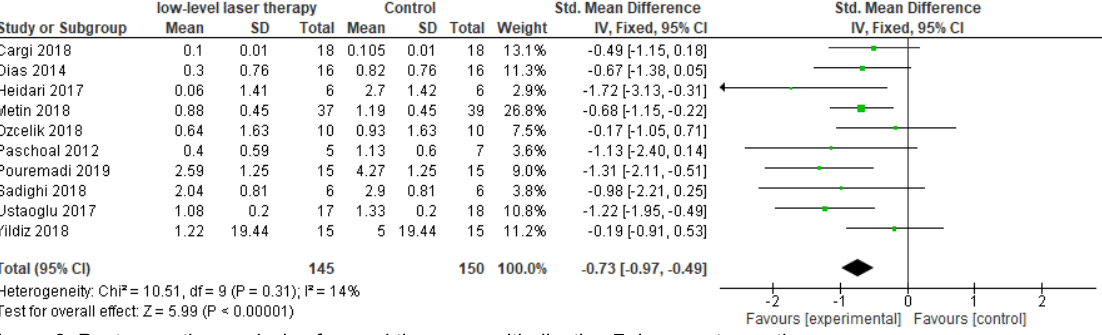
Figure 3. Post-operative analysis of wound tissue re-epithelization 7 days postoperative